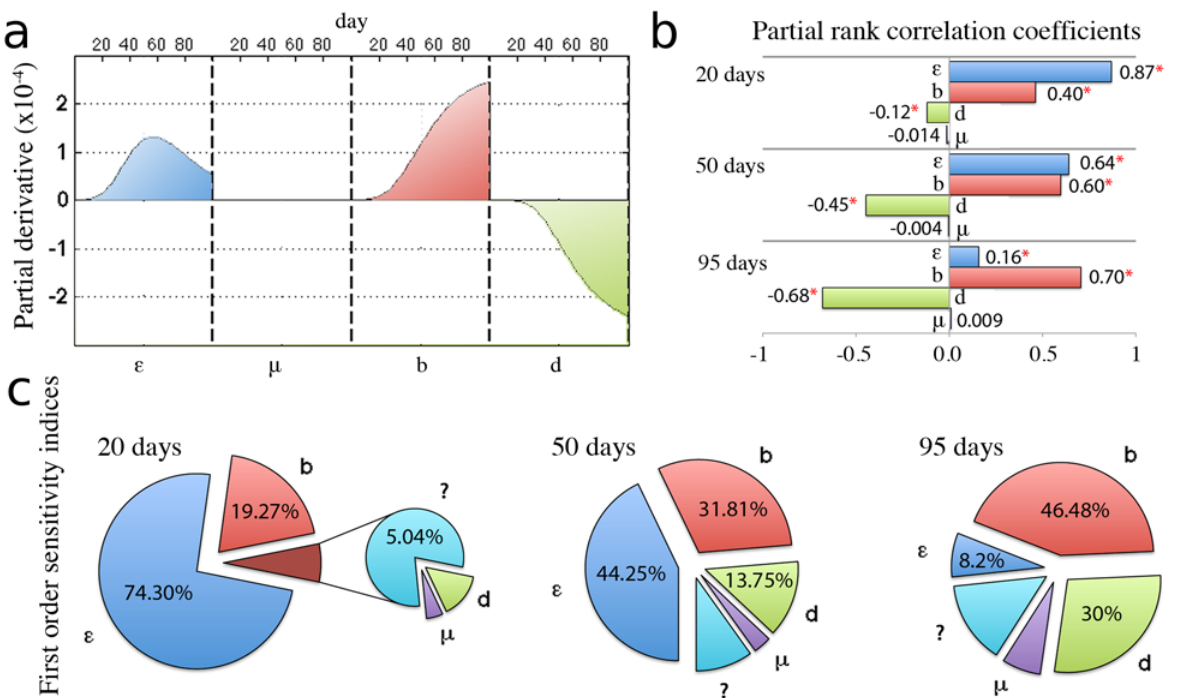
Fig 2. Local and global sensitivity analysis for the control case. Analysis carried with the nominal parameters values presented in Table 1. (a) Time evolution of the local sensitivities, defined as the partial derivatives of the tumor growth curve taken with respect to each parameter and multiplied by the nominal parameter value. (b) Partial rank correlation coefficients between each parameter and the tumor volume after 20, 50 or 95 days from initiation. Coefficients were calculated from 1,000 randomly generated samples under the assumption that each parameter is uniformly varied by no more than 10% of its initial value ( * denotes p-value below 0.01). (c) First order sensitivity indices, defined as the fraction of the total variance in tumor volume caused by the variation in each parameter value. Calculations were performed after 20, 50 and 95 days from tumor initiation using the FAST method and under the assumption that parameters are varied uniformly by no more than